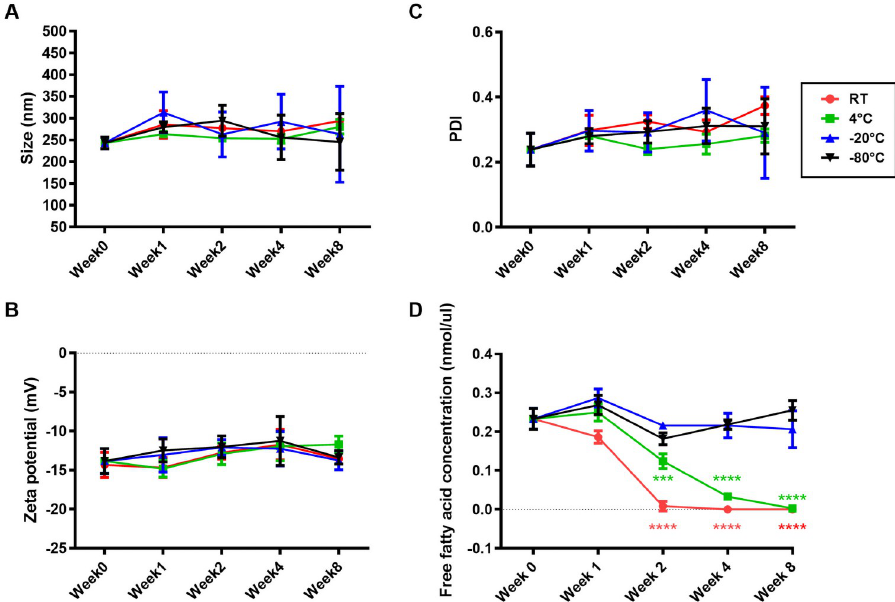
Fig 3. Determination of KPEVs stability in different storage temperatures. The (A) size distribution, (B) zeta potential, and (C) PDI of the KPEVs stored at 4˚C, − 20˚C, or − 80˚C for 0, 1, 2, 4, or 8 weeks were analyzed by DLS. (D) The free fatty acid contents of the stored KPEVs were analyzed using an ELISA kit. The experiments were performed in at least triplicates, and the data are presented as the mean ± SD. The statistical analysis was performed using two-way ANOVA followed by the Bonferroni test. ( ��� ) and ( ���� ) indicate P-values of p � 0.001 and p � 0.0001 compared to KPEVs on week 0, respectively.